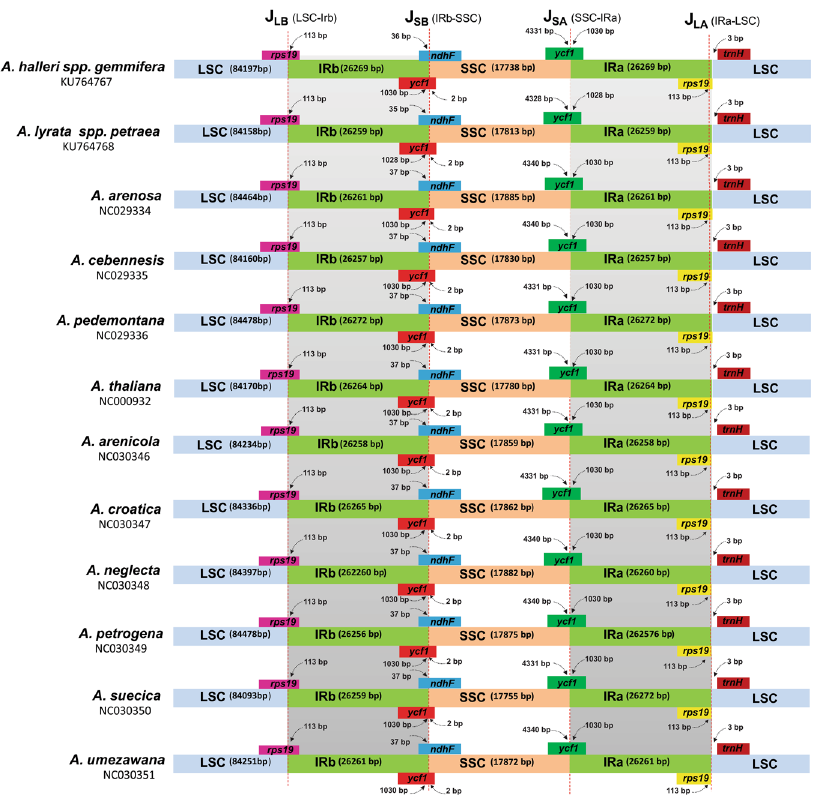
Figure 6. Comparison of border distance between adjacent genes and junctions of LSC, SSC, and two IR regions among the chloroplast genomes of twelve Arabidopsis species. Boxes above or below the main line indicate the adjacent border genes. The figure is not to scale with respect to sequence length and only shows relative changes at or near the IR/SC